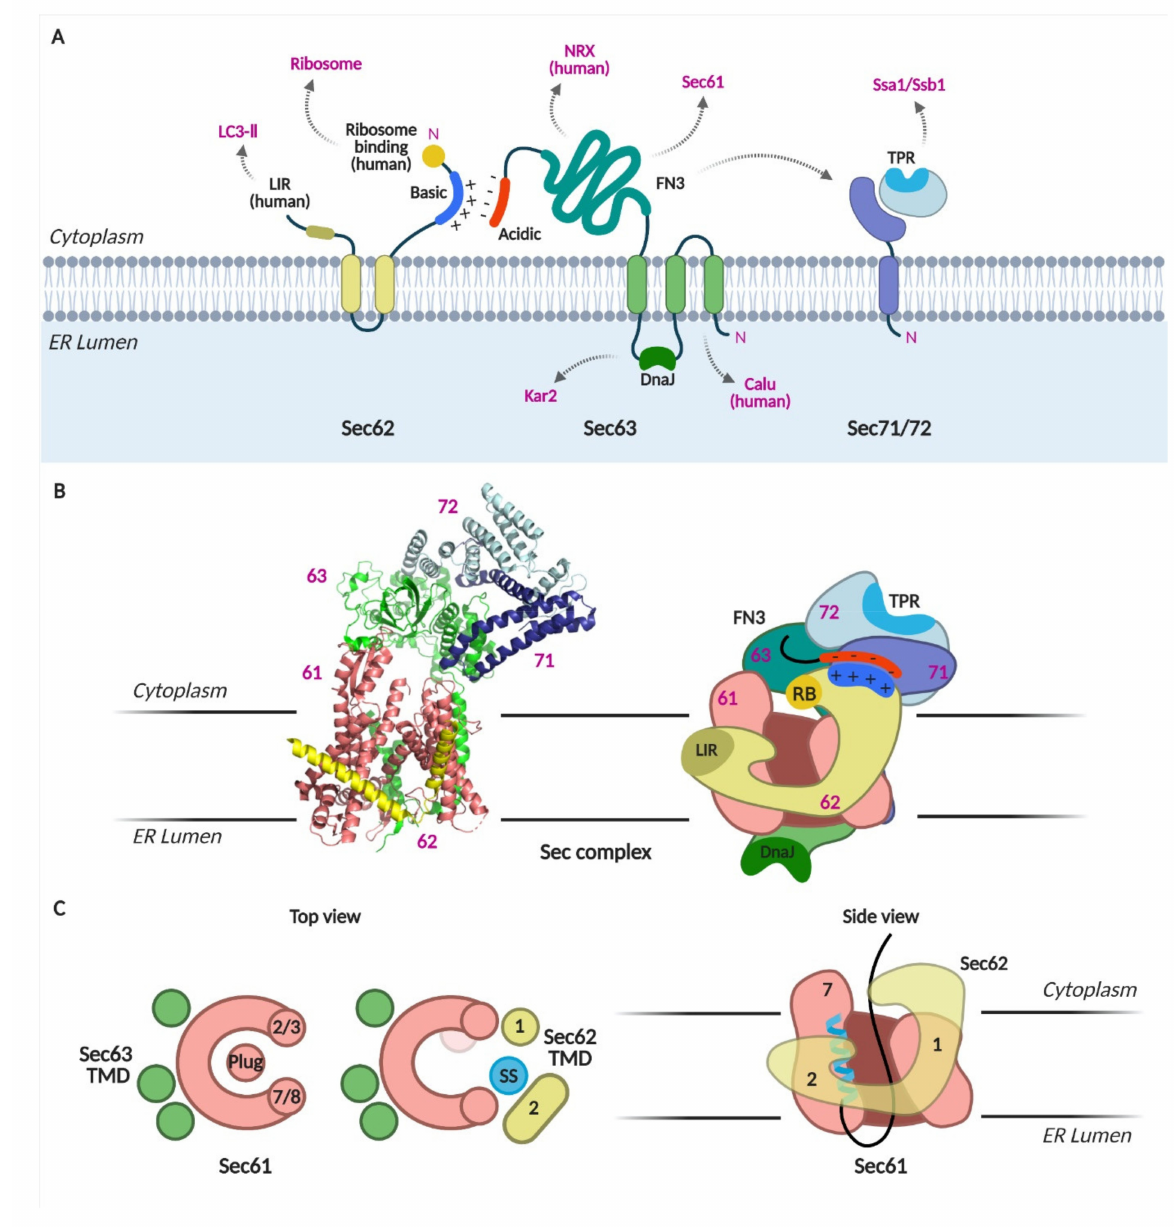
Figure 2. The Sec complex. ( A ) Schematics of Sec62, 63, 71, and 72. Domains and interacting proteins are indicated. LIR, LC3-interacting region; TPR, tetratricopeptide repeat; FN3, fibronectic type III; NRX, nucleoredoxin; calumenin, calu. ( B ) Cryo-EM structure of the Sec complex from S. cerevisiae . Itskanov, S., Park, E. (2020) Cryo-EM structure of the Sec complex from S. cerevisiae , wild-type, class with Sec62, conformation 1 (C1) doi: 10.2210/pdb7KAI/pdb (PDB code 7KAI) created with PyMOL [5]. Schematic of the Sec complex is based on the cryo-EM structure in [5]. ( C ) Channel opening by binding of Sec63, 62 and signal sequence to Sec61